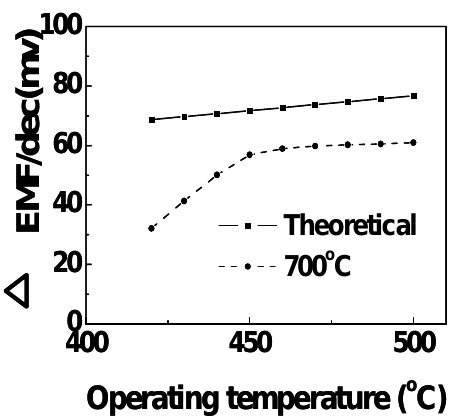
Figure 4. Dependence of ∆ EMF/dec as a function of operating temperature ( o C).